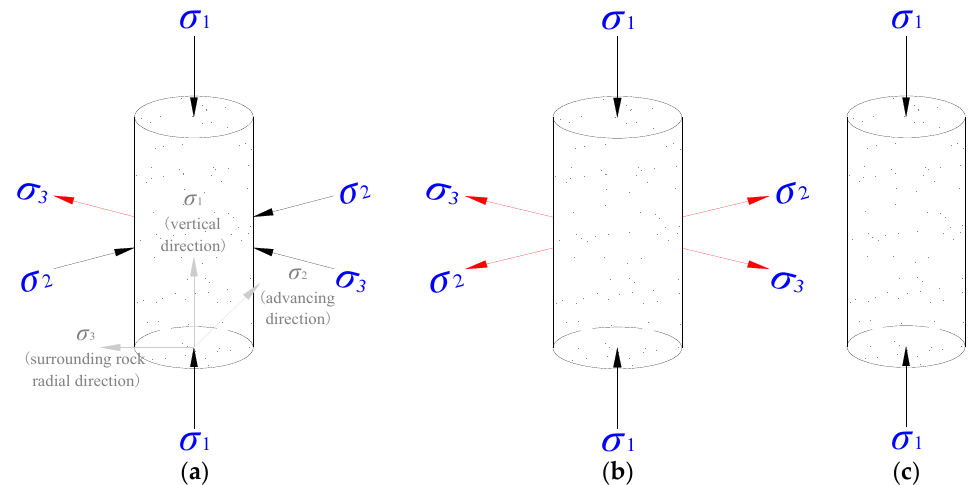
Figure 10. An unloading comparison between the excavation and the test: ( a ) excavation unloading, ( b ) experiment unloading, and ( c ) uniaxial compression.